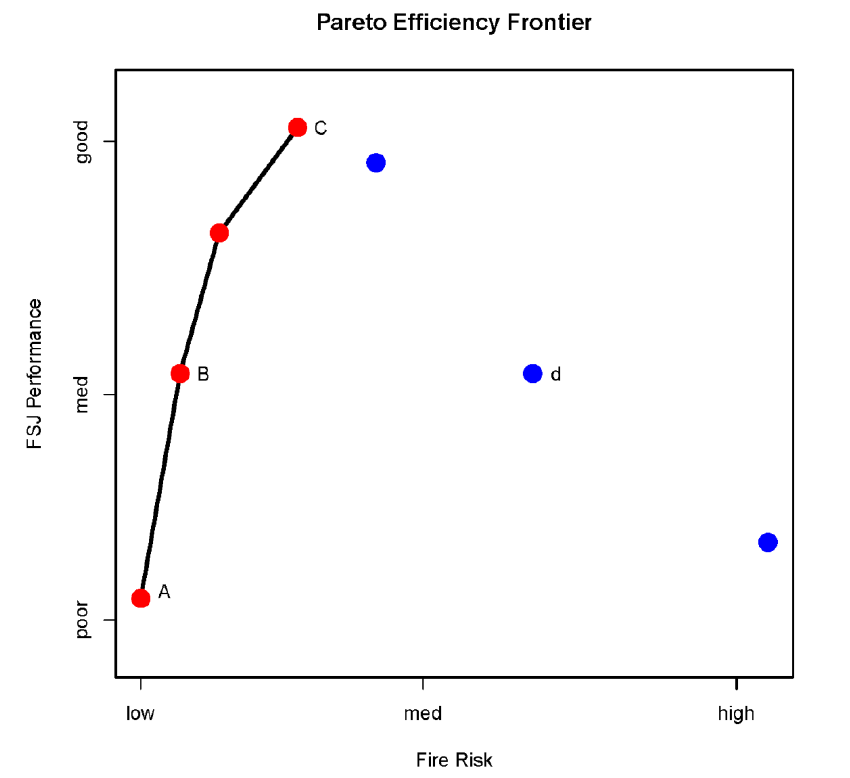
Figure 1. A plot of management strategy returns (benefits), parsed by two objectives: fire risk and response by Florida scrub-jays (FSJs). The line passes through those strategies that are Pareto optimal (red dots), which depict the most efficient solution for one objective at a given benefit for the other objective. The efficiency frontier suggests that no greater benefit can be achieved for one objective without a loss to the other and represents the subset of solutions for which it makes sense to negotiate a final strategy. The blue points are sub-optimal or dominated solutions, which can be improved upon for one or both objectives (up to the efficient frontier) without loss to the